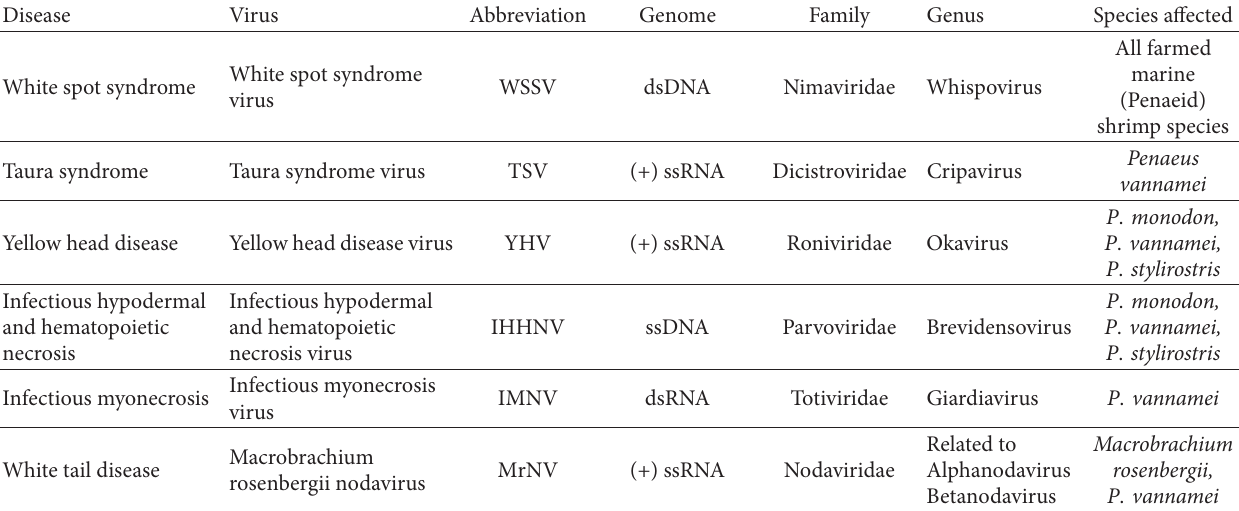
Table 1: Viral diseases of